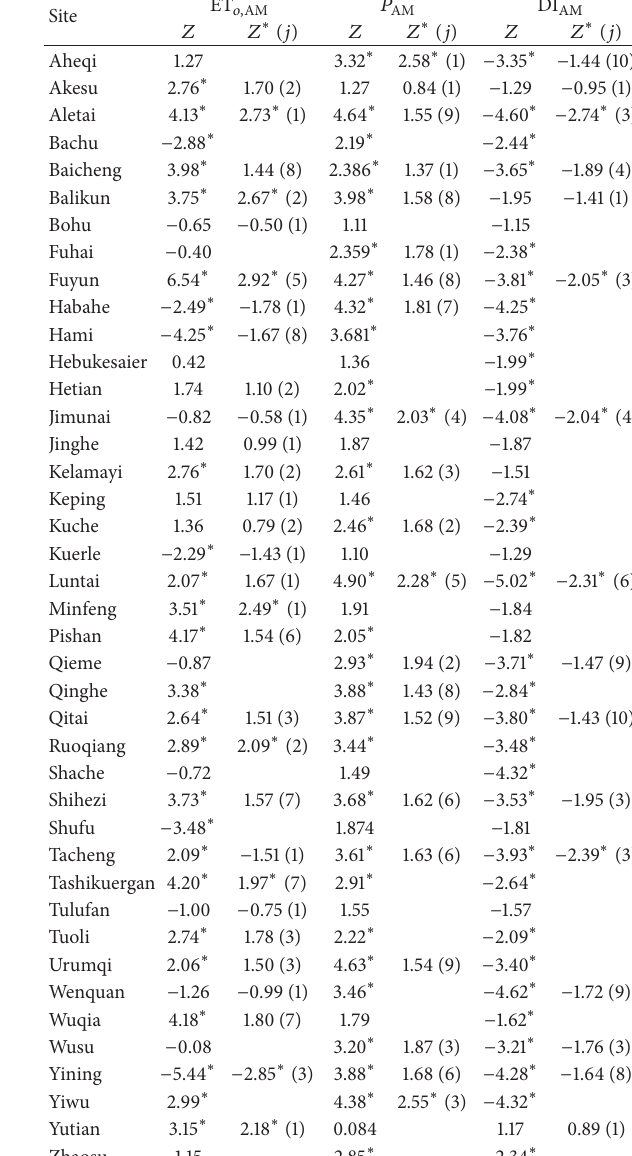
Table 2: Area weights ( 𝐴 𝑊 ) of the studied sites in Xinjiang, China. Table 3: Trend detection results over